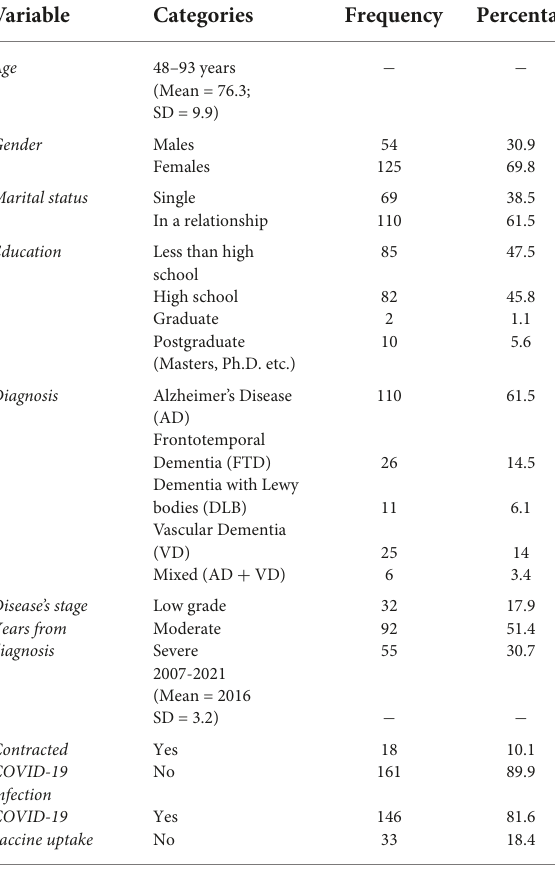
TABLE 1 Demographic characteristics of family caregivers. TABLE 2 Demographics and clinical characteristics of